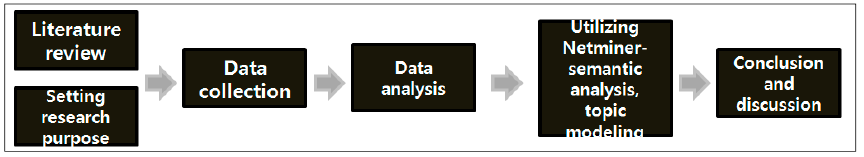
Figure 1. Research process .